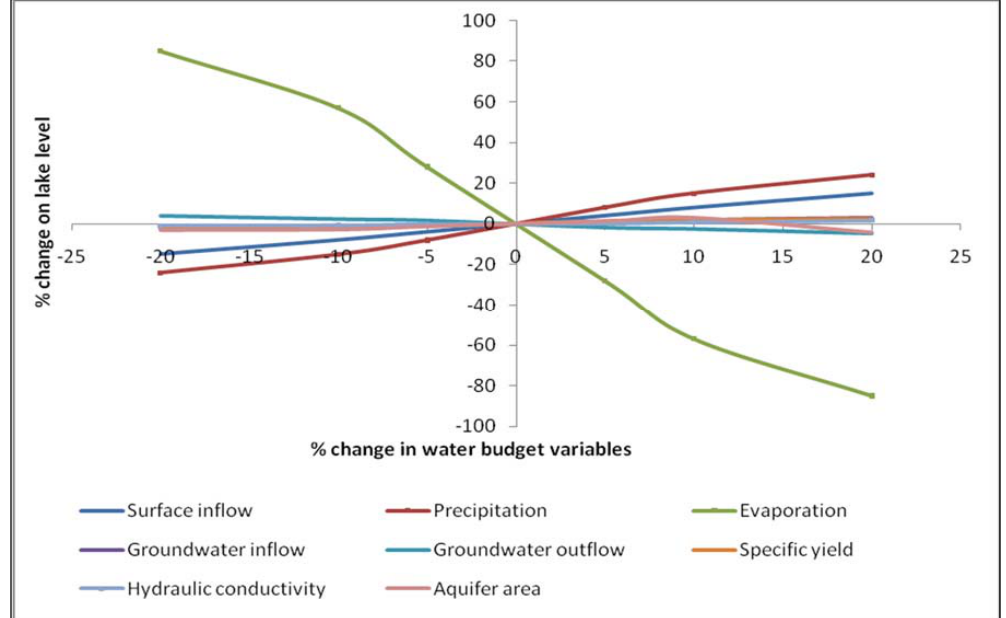
Figure 15. Relative sensitivity of Lake Linlithgow water balance model to changes in the water budget components.